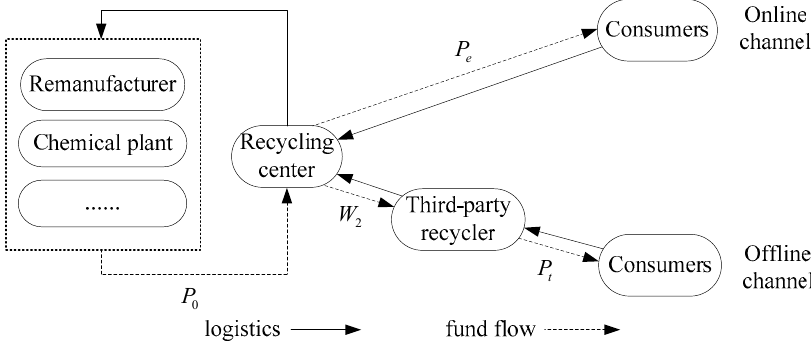
Figure 1. Depiction of the dual-channel reverse supply chain (DRSC).